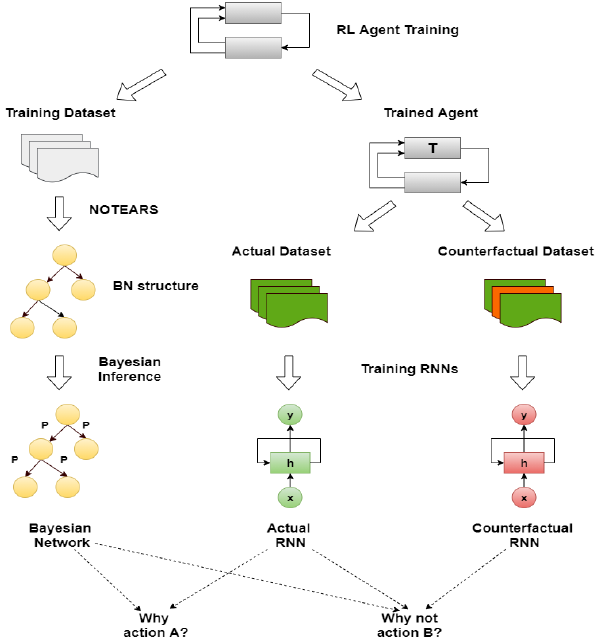
Figure 2. Pipeline of the proposed